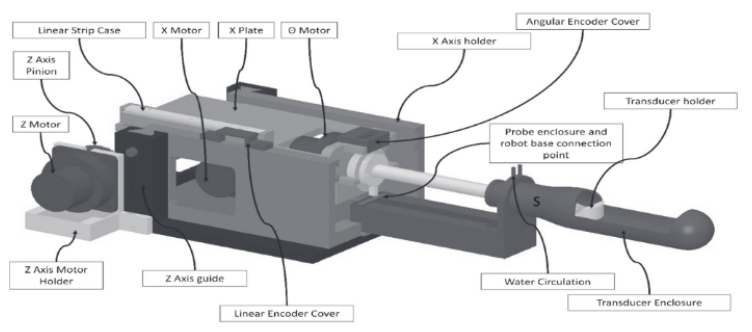
Figure 14. Transducer positioning system by Yiallouras et al. for transrectal treatment of prostate diseases